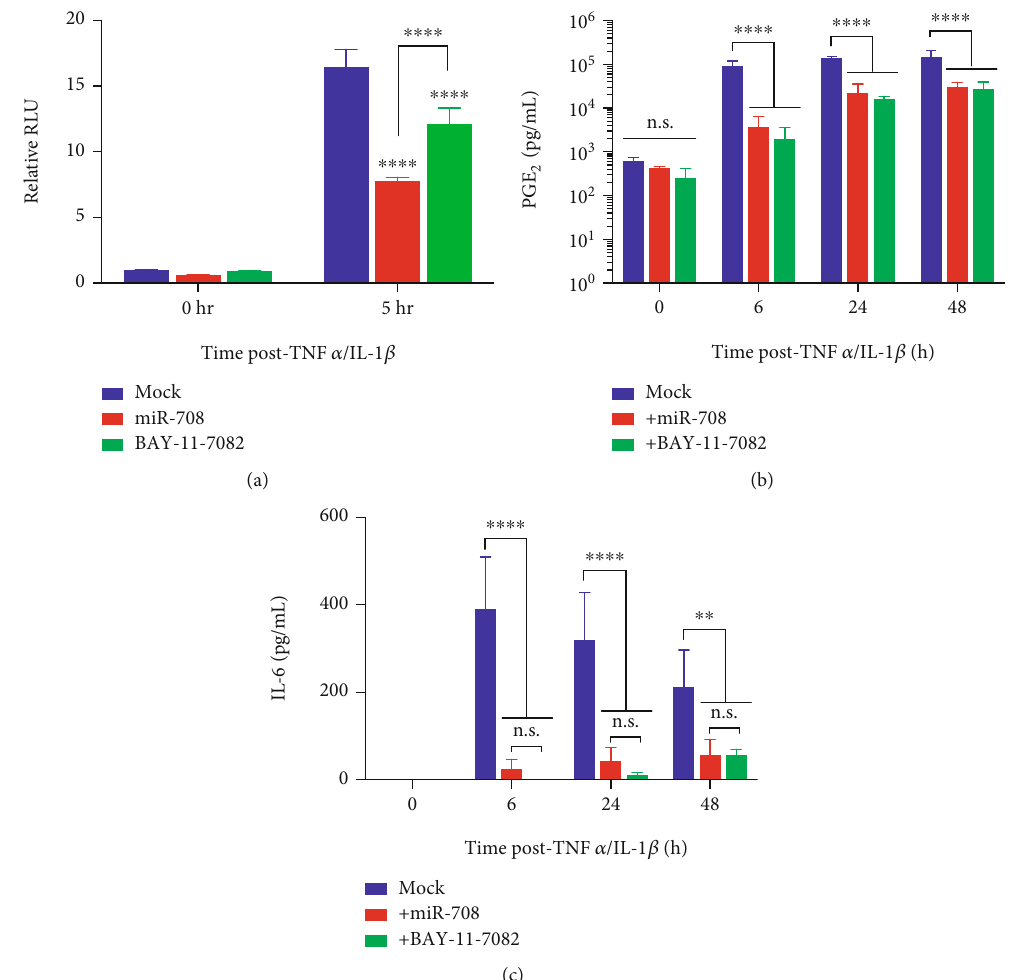
Figure 6: miR-708suppressesPGE andIL-6secretionbyinhibitingNF- κ Bsignalingindiseasedlungcells.(a) RelativeNF- κ Bpromoterreporter 2 NanoLuc luciferase activity in A549 cells. Relative luciferase activities were measured in response to mock (blue), 25nM miR-708 (red), or 10 μ M BAY-11-7082 (green) treatment for 0 or 5h. Data were normalized to total protein and mock 0h samples. Di ff erences were compared between samples within 0 and 5h time points. (b) ELISA measuring exogenous PGE levels in A549 cells cotreated with vehicle (blue), 25nM miR-708 2 (red), or 10 μ M BAY-11-7082 (green) and TNF α /IL-1 β for 0 – 48 hours. (c) ELISA measuring exogenous IL-6 levels in A549 cells cotreated with vehicle (blue), 25nM miR-708 (red), or 10 μ M BAY-11-7082 (green) and TNF α /IL-1 β for 0 – 48 hours. ∗∗ p < 0 : 01 and ∗∗∗∗ p < 0 : 0001 , n ≥ 3 .